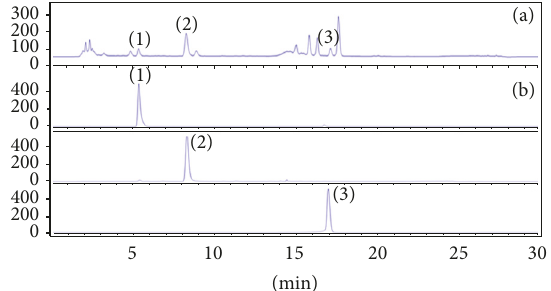
Figure 1: HPLC chromatogram of SV extract collected in Ulleung Island in April at 254 nm detection. Peaks of SV aqueous extract (a) and standardization of the three marker compounds (b): (1) protocatechuic acid; (2) chlorogenic acid; (3) kaempferol-3- O -